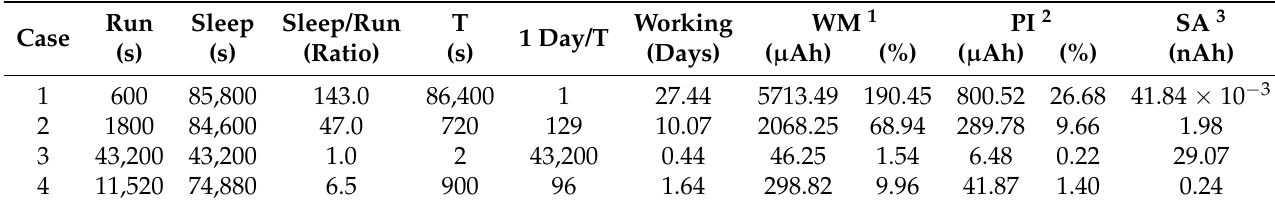
Table 7. Required electric charge for given underwater measurement